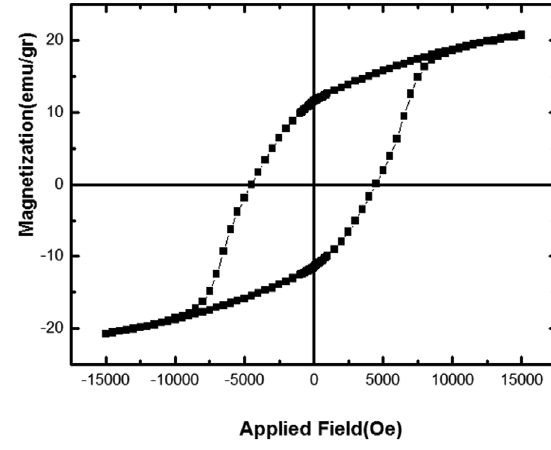
Figure 15: EDX of nanocomposite SrFe